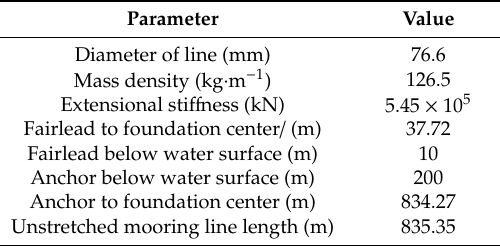
Table 7. Mooring line properties.